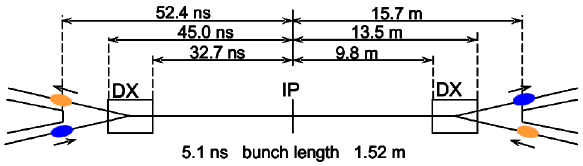
FIG. 3. Schematic of the RHIC interaction regions.